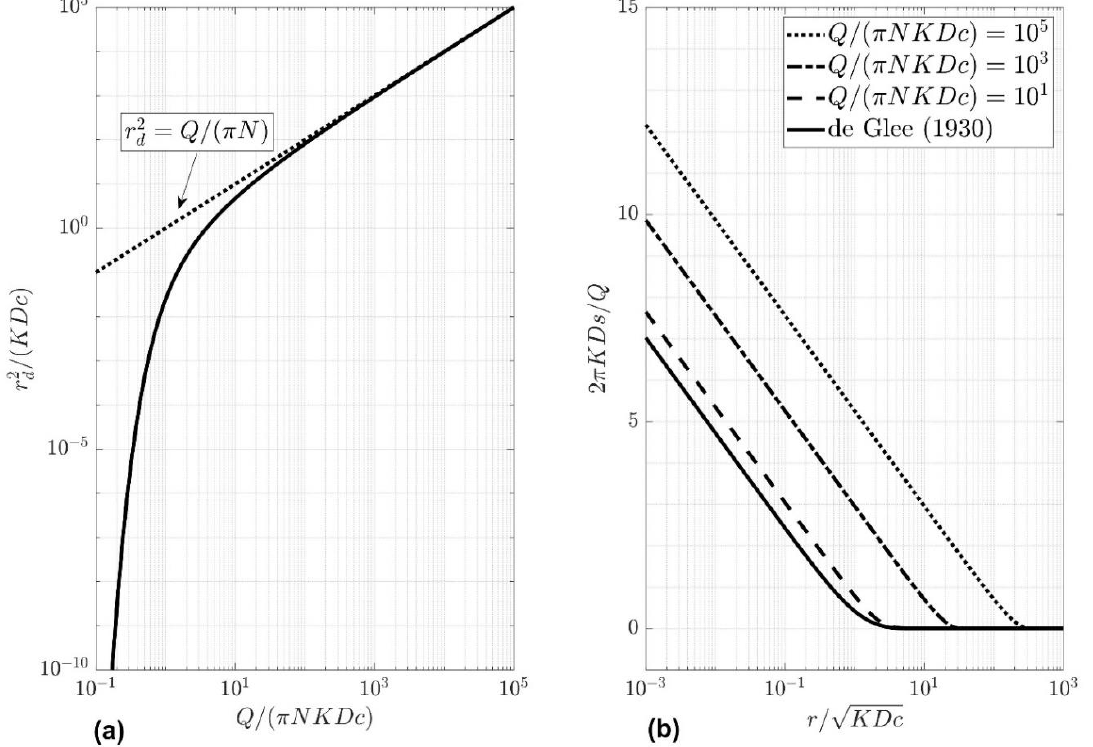
Figure 3. Solution of the Ernst model. ( a ) Dimensionless extent of the no-drainage zone r d /( KDc ) 1/2 versus dimensionless pumping rate Q /( π NKDc ). The dotted line is the asymptotic solution for zero resistance. ( b ) Dimensionless drawdown (2 π KDs )/ Q versus dimensionless distance r /( KDc ) 1/2 for different values of dimensionless pumping rate Q /( π NKDc ). The solid line is the de Glee solution. K is the aquifer conductivity, D the saturated thickness, c the drainage resistance, N the infiltration flux, Q the pumping rate, s the drawdown, r the radial distance, and r d the boundary between the zones without and with drainage. See text for definitions and a more detailed